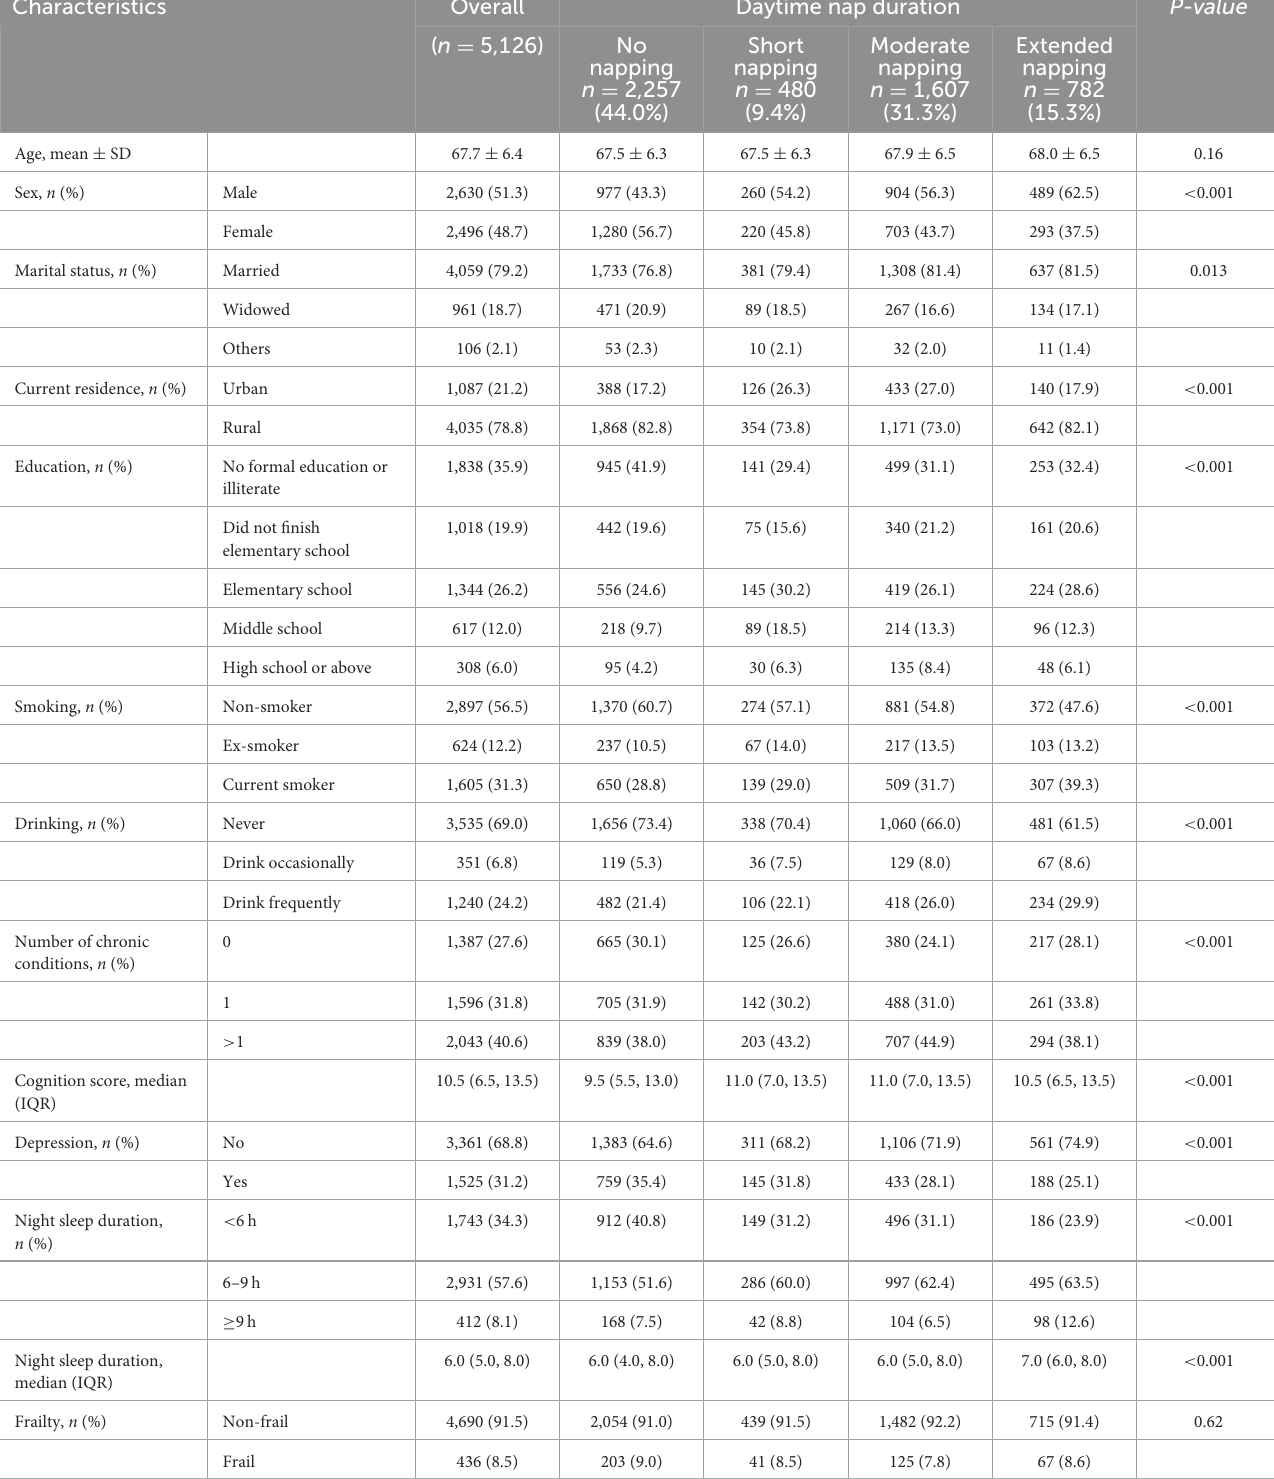
TABLE 1 Baseline characteristics of study sample grouped by daytime nap duration, the China Health and Retirement Longitudinal Study ( n = 5,126).